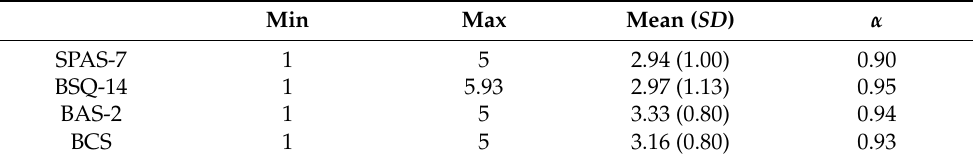
Table 3. Descriptive statistics and Cronbach’s alpha of the Social Physique Anxiety, Body dissatisfac- tion, and Body Compassion ( N =